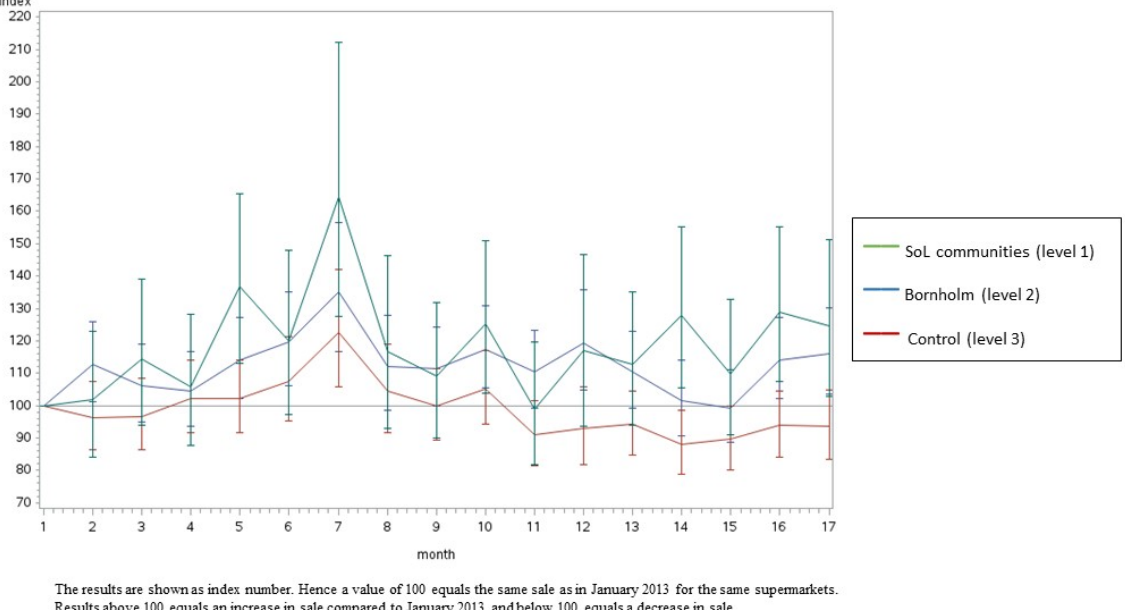
Figure 5. The development in monthly sales of oatmeal from January 2013 to June 2014 in the SoL intervention communities, the Island of Bornholm and the control area (Odsherred). Data are shown as index numbers.